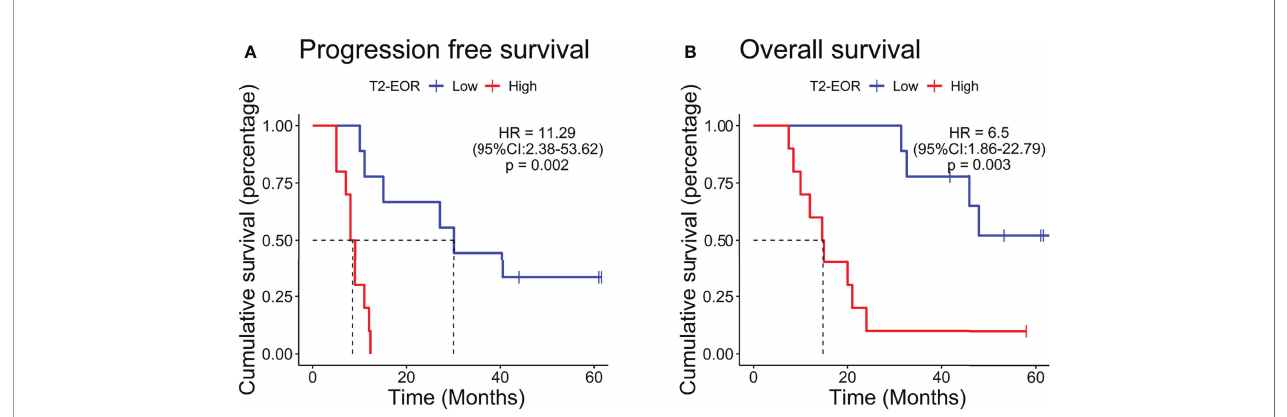
FIGURE 2 | Patients with increased T2-EOR exhibited poorer prognosis. Kaplan – Meier estimates of (A) progression-free survival and (B) overall survival in 19 GBM patients, which were divided into the high (T2-EOR ≥ median) and low (T2-EOR < median) T2-EOR groups. The log-rank test was applied to estimate the difference. Vertical lines indicate time points at which patients were